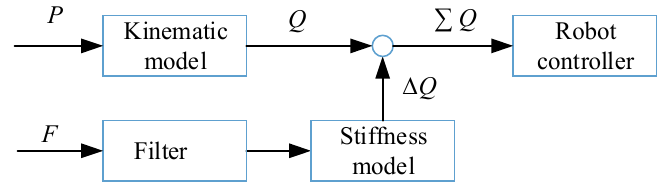
Figure 2. Block diagram of deformation compensation.